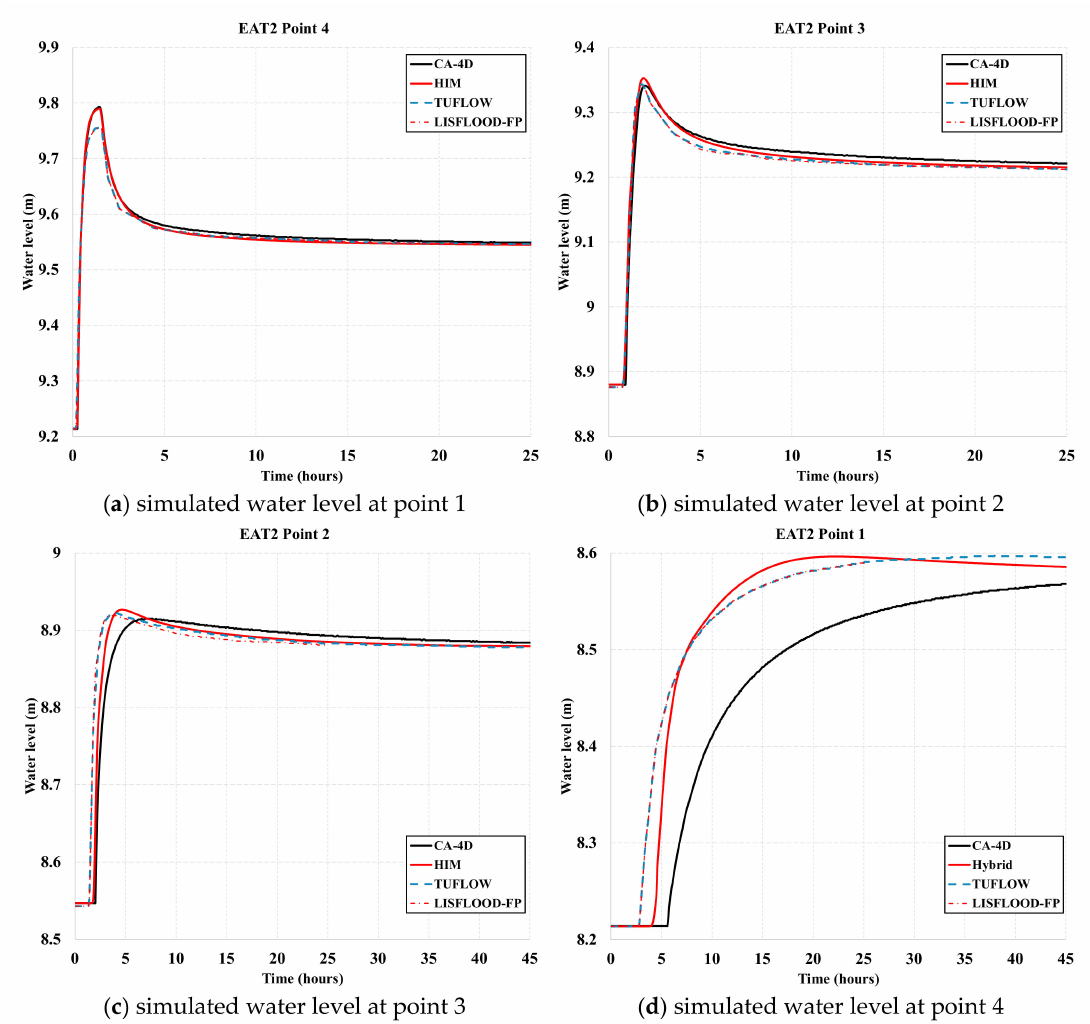
Figure 6. Temporal variation in the water level for EAT2 at points 1, 2, 3, and 4; comparison among the CA-4D, HIM, TUFLOW, and LISFLOOD-FP models. ( a ) simulated water level at point 1; ( b ) simulated water level at point 2; ( c ) simulated water level at point 3; ( d ) simulated water level at point